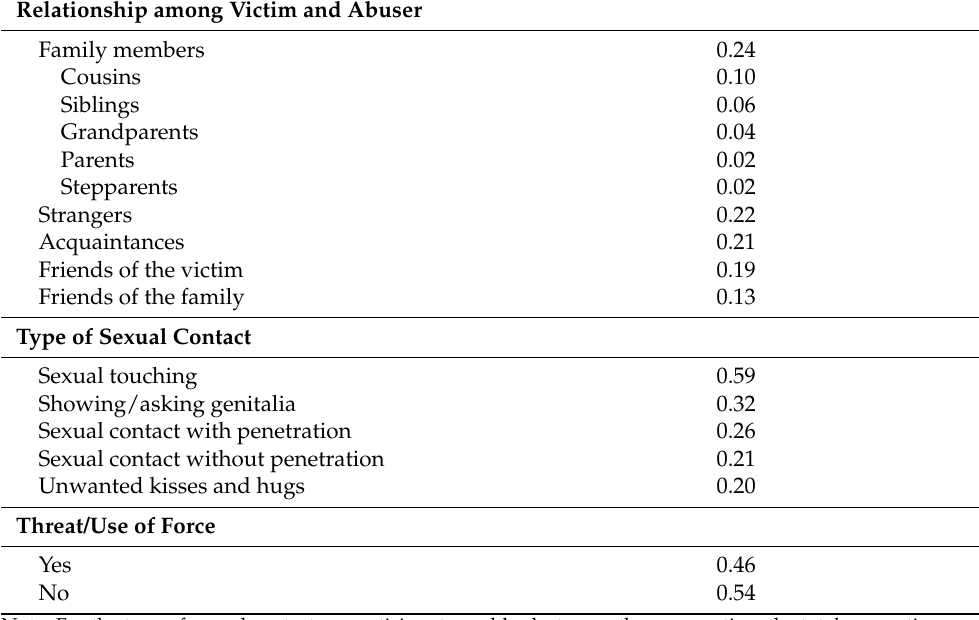
Table 2. Proportions of relationship among victim and abuser, type of sexual contact, and threat/use of